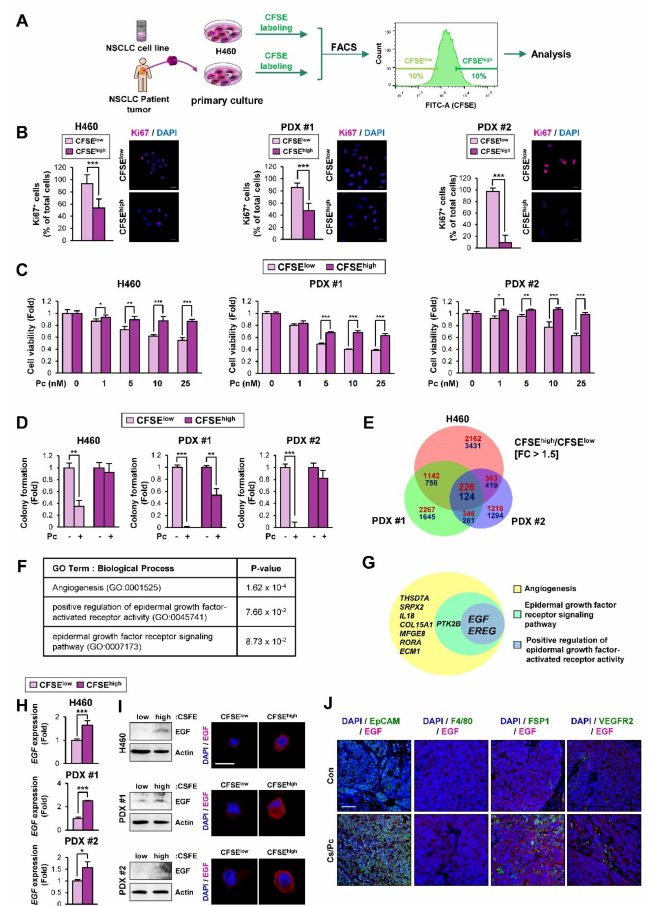
Figure 2. Enrichment of epidermal growth factor (EGF)-associated genes in the slow-cycling carboxyfluorescein diacetate succinimidyl ester (CFSE) high cell population. ( A ) A representative image showing the flow cytometric cell sorting of CFSE high and CFSE low cell populations. The top 10% and the bottom 10% of total cells were defined as CSFE high and CSFE low populations, respectively. ( B ) Reduced cell proliferation in the CFSE high population was determined by immunofluorescence staining using an anti-Ki67 antibody. Scale bar: 20 µ m. ( C, D ) Decreased sensitivity to paclitaxel in the CFSE high population was determined by the 3-(4,5-dimethylthiazol-2-yl)-2,5-diphenyltetrazolium bromide (MTT) ( C ) and anchorage-dependent colony formation ( D ) assays. ( E ) A Venn diagram showing commonly regulated genes in the CFSE high population from H460 cells and PDXs compared with those from the corresponding CFSE low populations. The Venn diagram was drawn using the freely available web-based tool [30] ( F ) Enrichment of GO terms associated with angiogenesis and the EGF pathway in the CFSE high population from H460 cells and PDXs, as determined by DAVID analysis. ( G ) A Venn diagram showing commonly regulated genes in the following GO terms: angiogenesis, epidermal growth factor receptor signaling pathway, and positive regulation of epidermal growth factor-activated receptor activity. The freely available web-based tool [30] was used for drawing the Venn diagram. ( H ) Commonly upregulated EGF expression in the CFSE high population compared with the corresponding CFSE low population was determined by real-time PCR. ( I ) Increase in the EGF protein expression in the CFSE high population compared with the CFSE low population was determined by Western blot and immunofluorescence (IF) analyses. Scale bar: 20 µ m. ( J ) Elevation of EGF expression in EpCAM + tumor cells in H460 xenograft tumors that relapsed after the completion of combinatorial chemotherapy (Cs / Pc) was determined by double IF analysis. Scale bar: 50 µ m. For all panels, the bars represent the mean ± SD. * p < 0.05, ** p < 0.01, and *** p < 0.001, as determined by two-tailed Student’s t